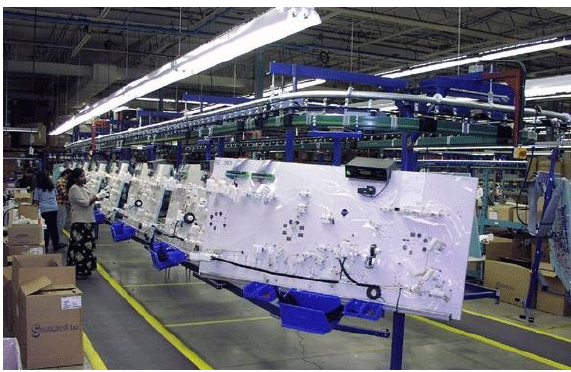
Figure 1. The wire harness paced assembly conveyor (often referred to as a rotary) contains assembly tables consisting of connector and clip fixtures [18].